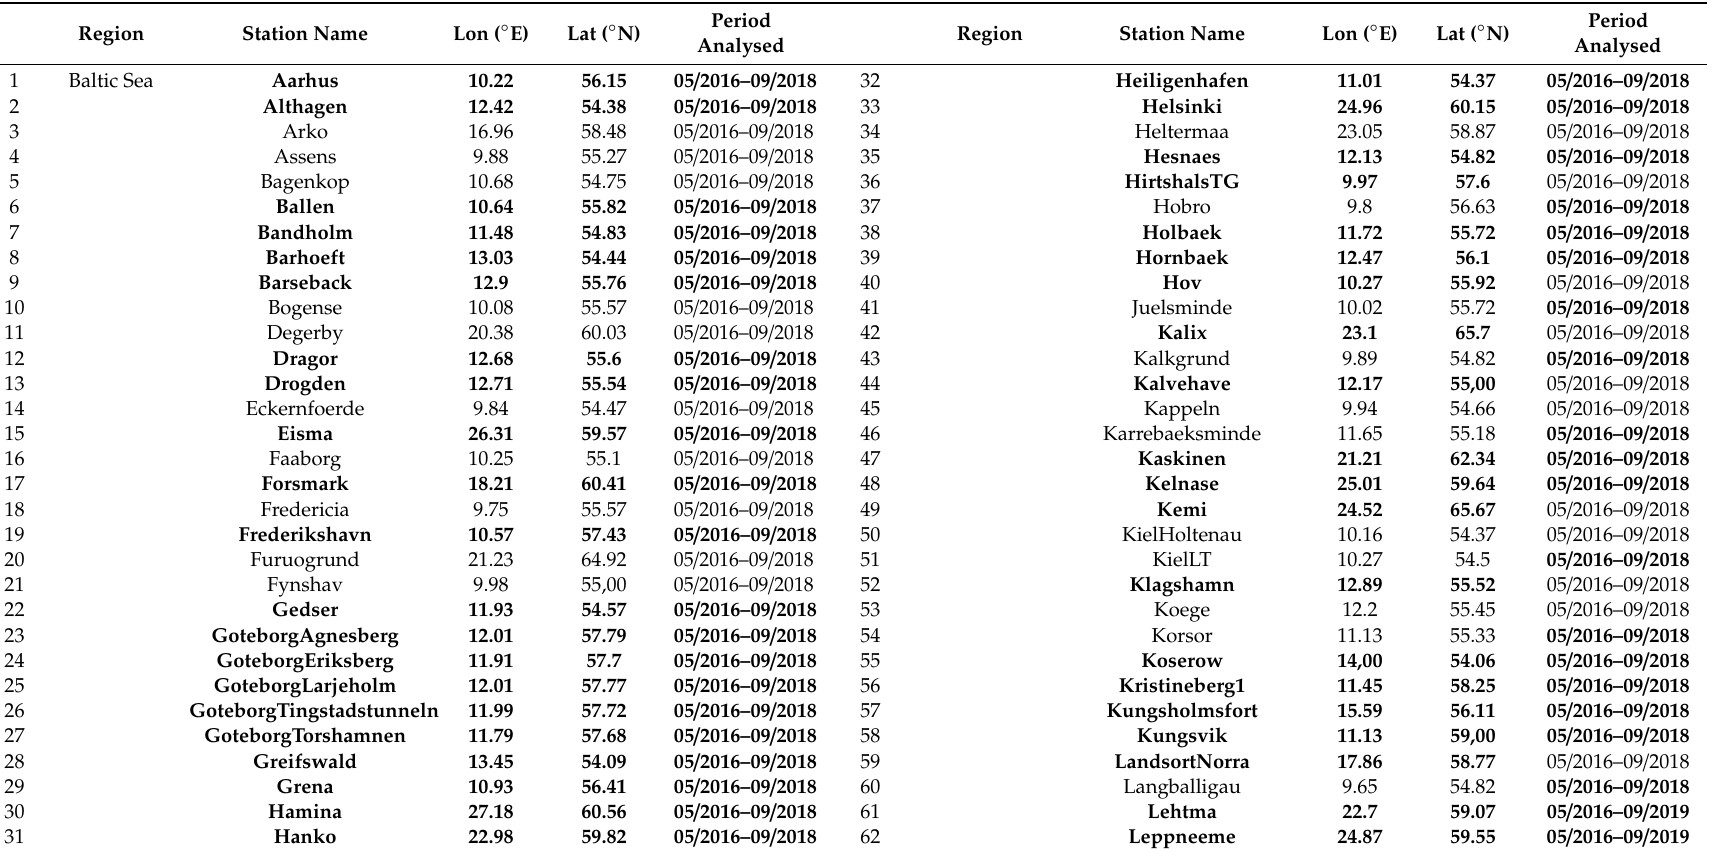
Table A1. List of tide gauge records with their location and the time period analysed. Bold stations were used in the inter-comparisons with altimetry data, whilst non-bold ones were rejected because they presented spurious data and / or did not keep the selection criteria described in the